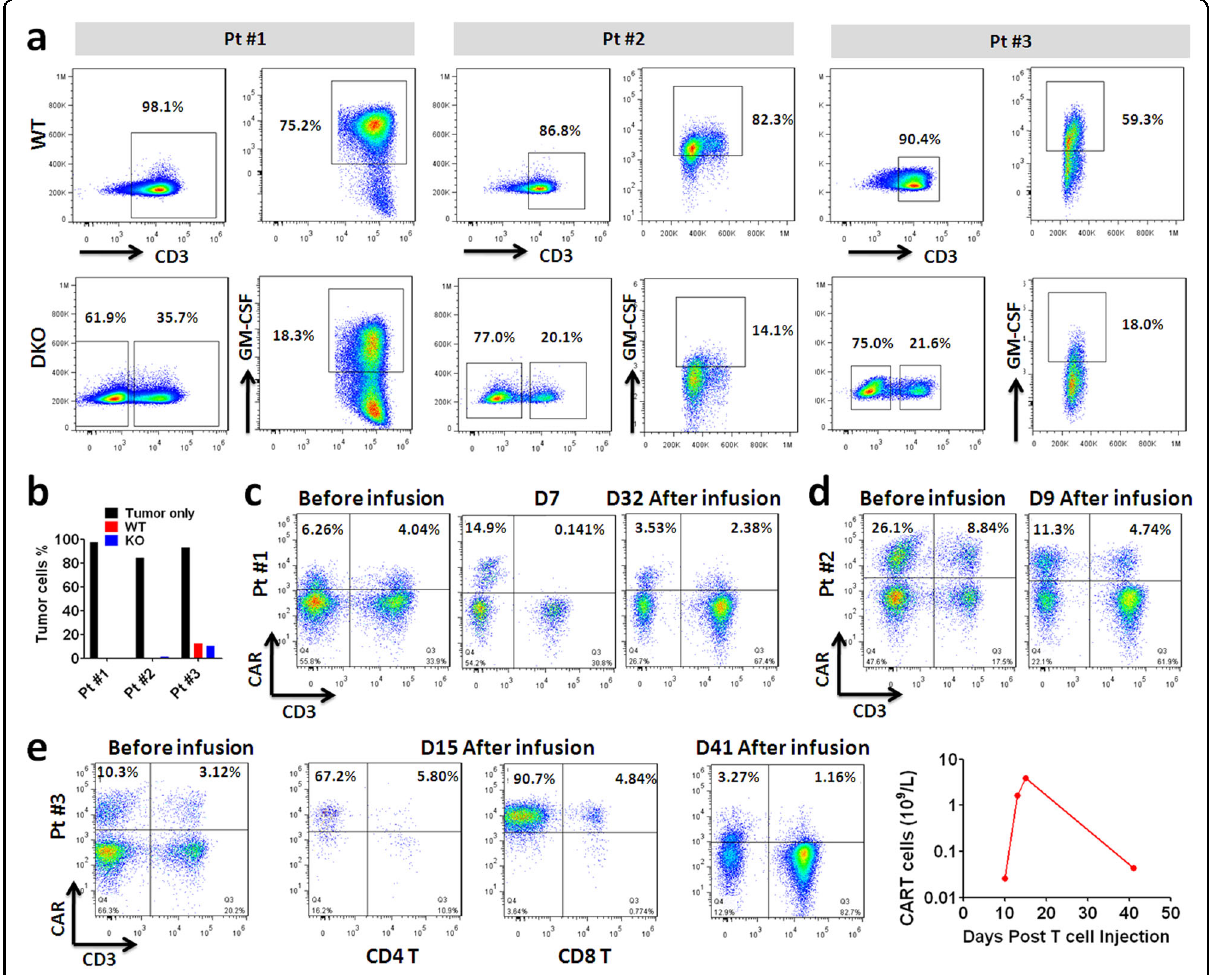
Fig. 3 Expansion of CRISPR-edited autologous anti-CD19 or anti-BCMA CART-aIL6/IL1RA with GM-CSF/TCR KO in patients. a Ef fi ciency of GM-CSF and TCR KO in CART-aIL6/IL1RA during ex vivo expansion. b Cytotoxicity of anti-CD19 or anti-BCMA CART-aIL6/IL1RA with GM-CSF/TCR KO or WT counterpart. c – e Frequencies of CRISPR-edited CD3 – CART cells in patient #1 ( c ), patient #2 ( d ), patient #3 ( e ), before and after